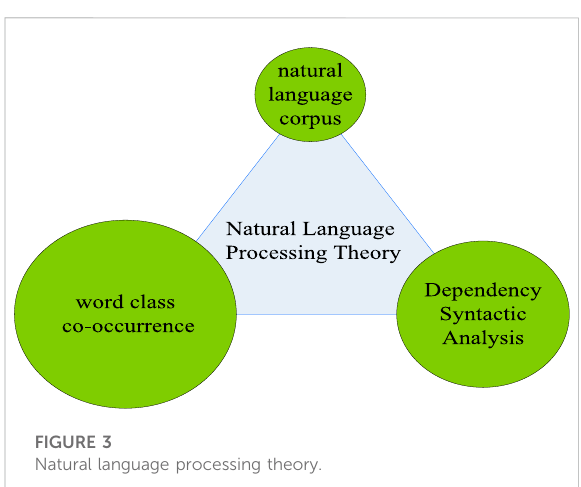
FIGURE 3 Natural language processing